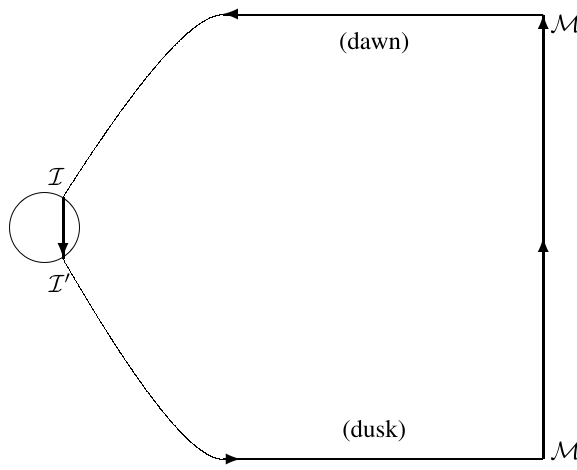
Fig. 1. Schematic diagram of region 1 currents in Northern Hemi- sphere, viewed from above the north pole (Sun to the left).